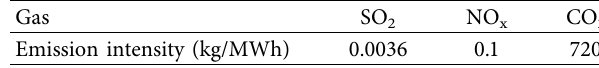
Table 1: Gas emission intensities